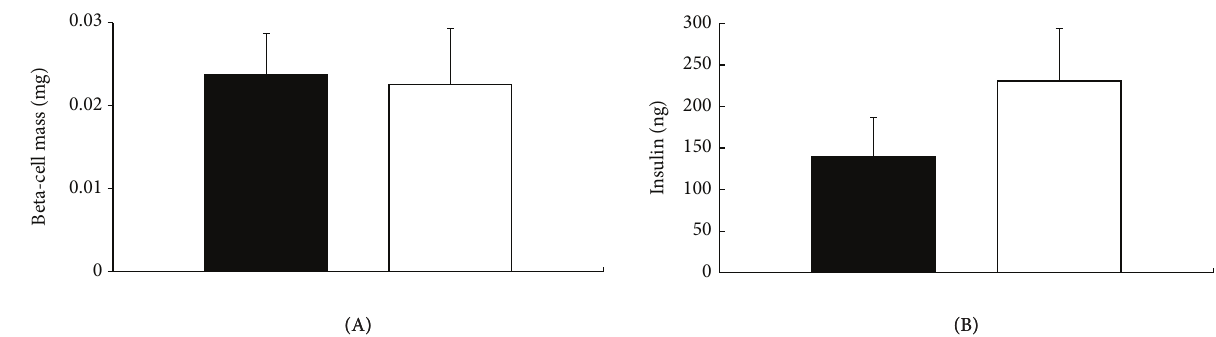
Figure 4: The graft 𝛽 -cell mass (A) and insulin content (B) at 6 weeks in islet recipients with (black column) and without (white column) MK-0431